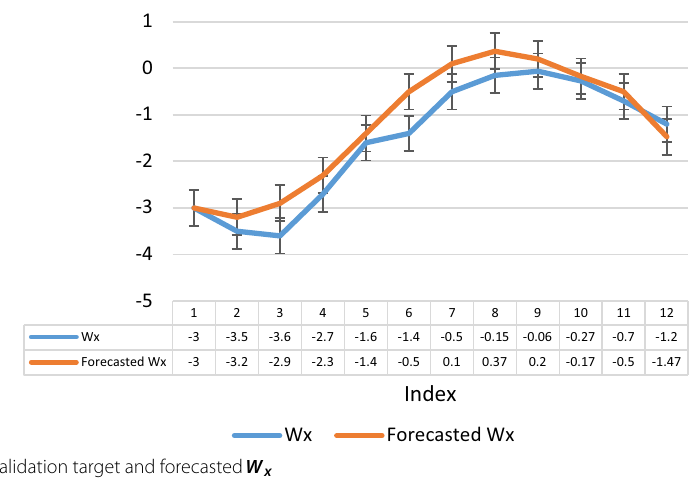
Fig. 26 Validation target and forecasted W